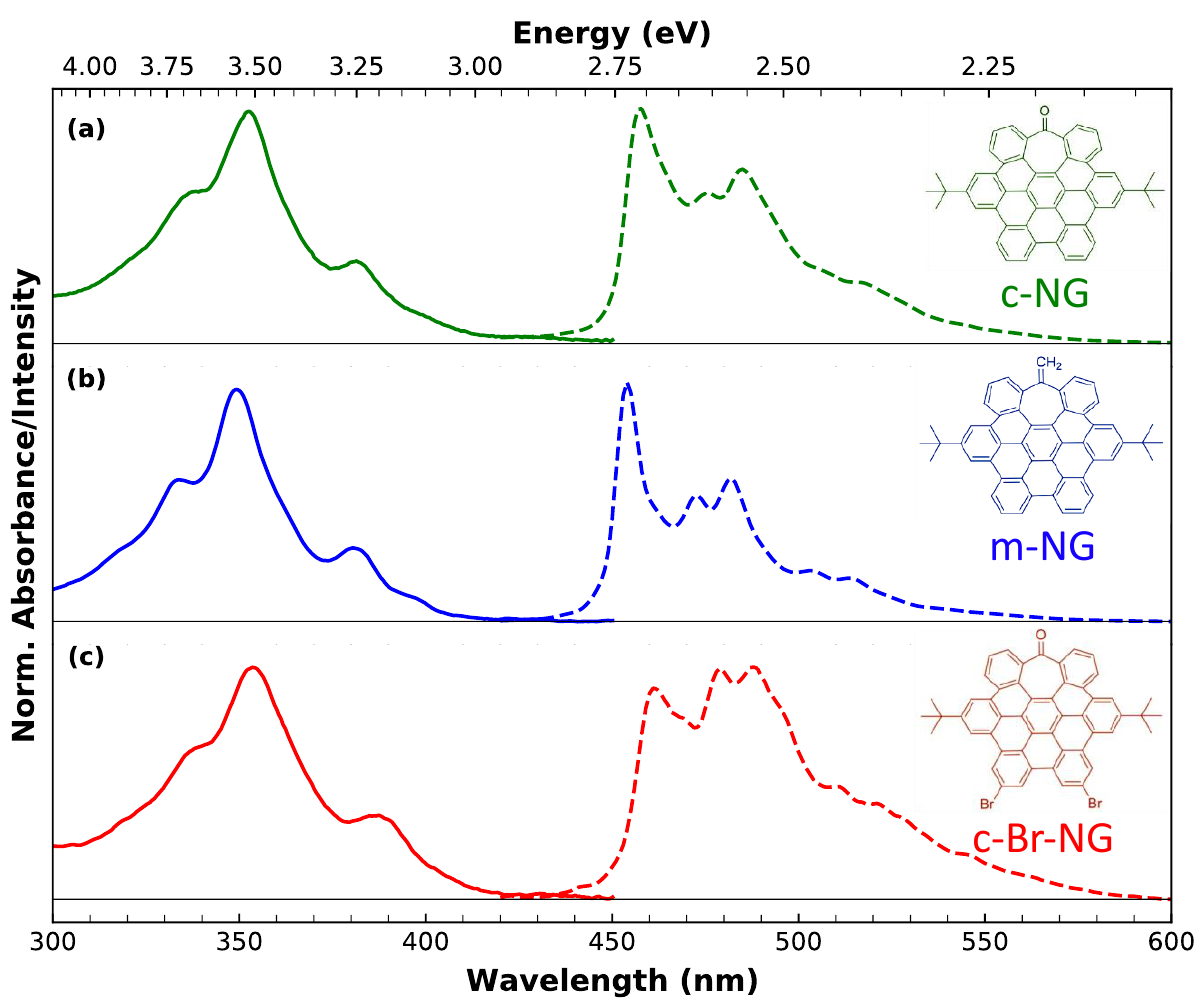
Figure 1. Normalized absorption (continuous lines) and photoluminescence (dashed lines) of ( a ) c-NG , ( b ) m-NG and ( c ) c-Br-NG in dichloromethane. The photoluminescence spectra were collected upon excitation at 350 nm. The corresponding chemical structure of each nanographene is reported on the right of the respective subpanel.